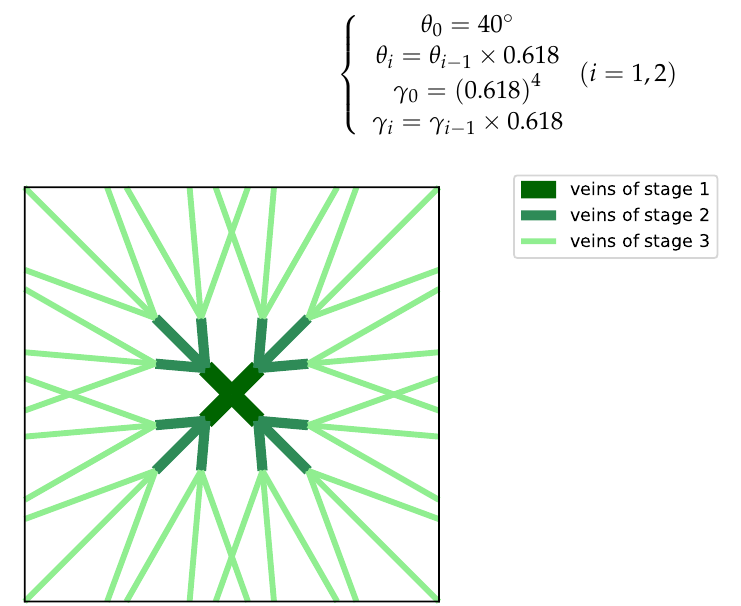
Figure 8. Leaf vein model for two working conditions.